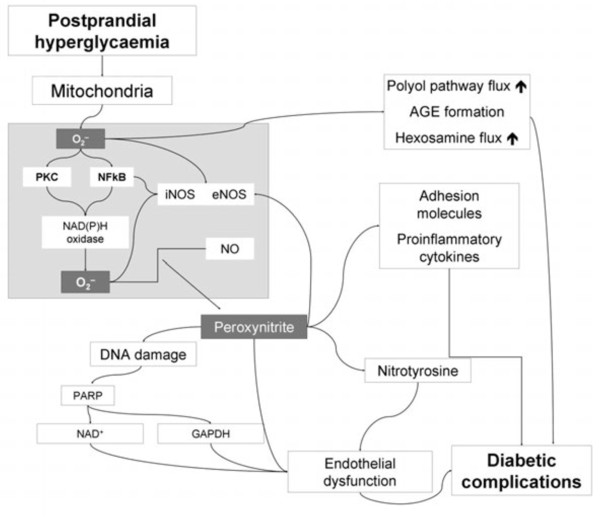
Pathogenesis of diabetic complications: Hyperglycemia-induced overproduction of superoxide by the mitochondrial electron-transport chain is supposed to be the key element. By activation of different pathways, the formation of the strong oxidant peroxynitrite is favoured, which in turn is damaging DNA. Through several intermediate steps, acute endothelial dysfunction, contributing to the genesis of diabetic complications, is triggered [13].